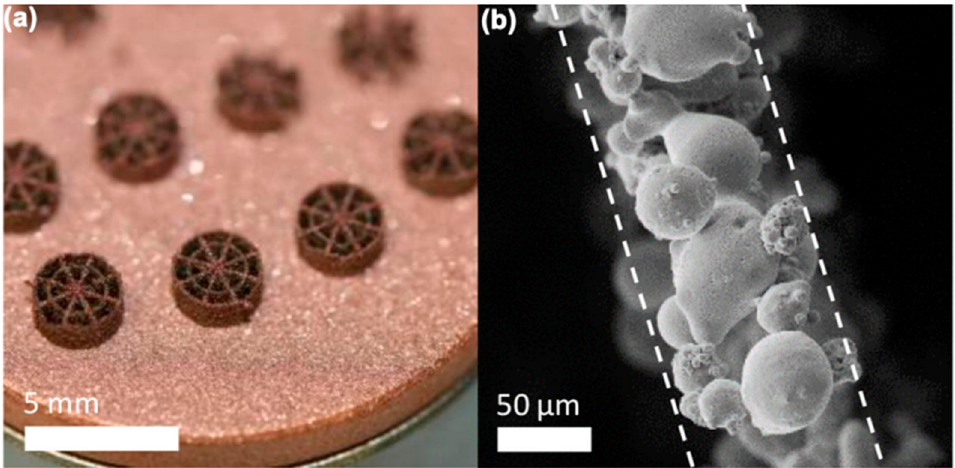
Figure 8. ( a )Typical sample of thin-wall structures with diameter of 3 mm processed with different laser parameter sets. ( b ) SEM image of a single wall with a thickness below 100 µm, which is marked by the dashed lines. A pulse energy of 1.0 µJ and scan velocity 666 mm/s was applied [64].